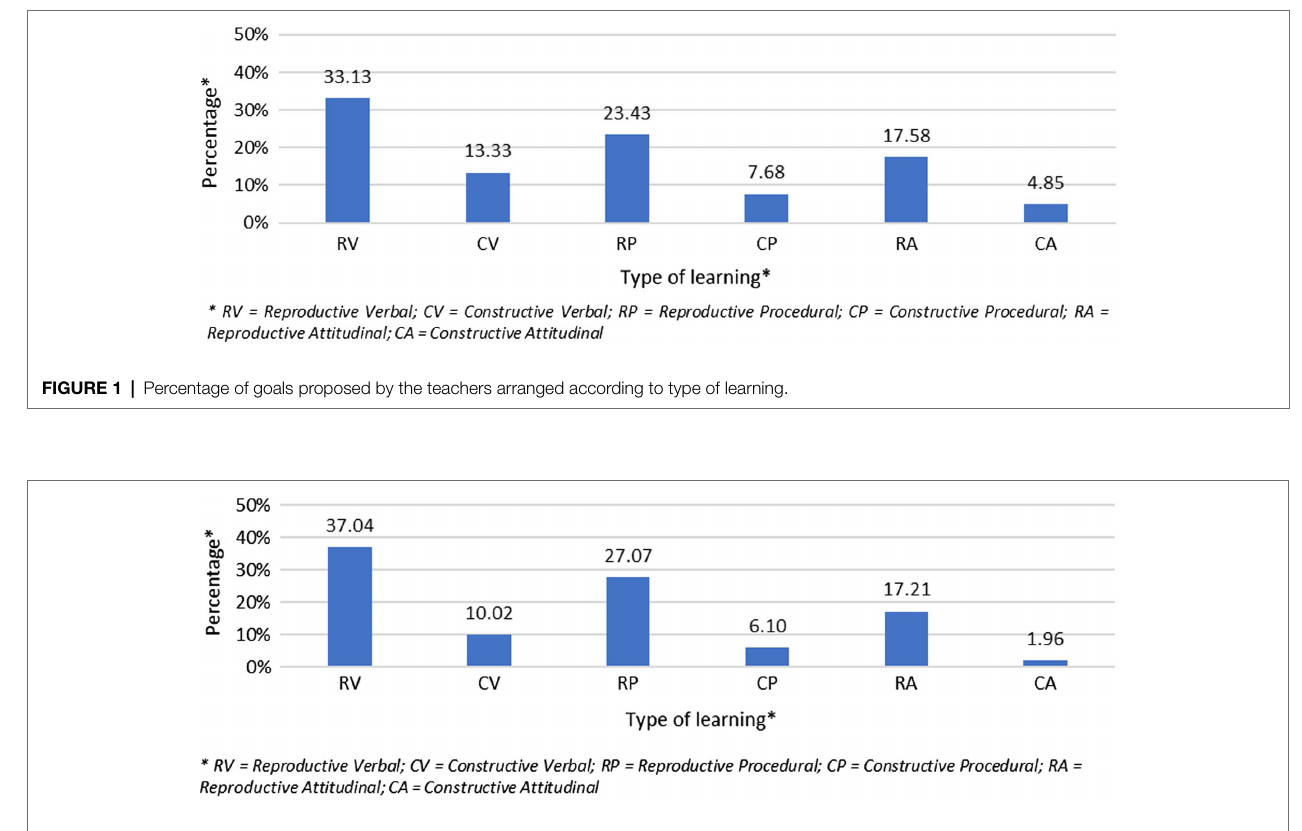
FIGURE 2 | Percentage of types of learning involved in the activities.